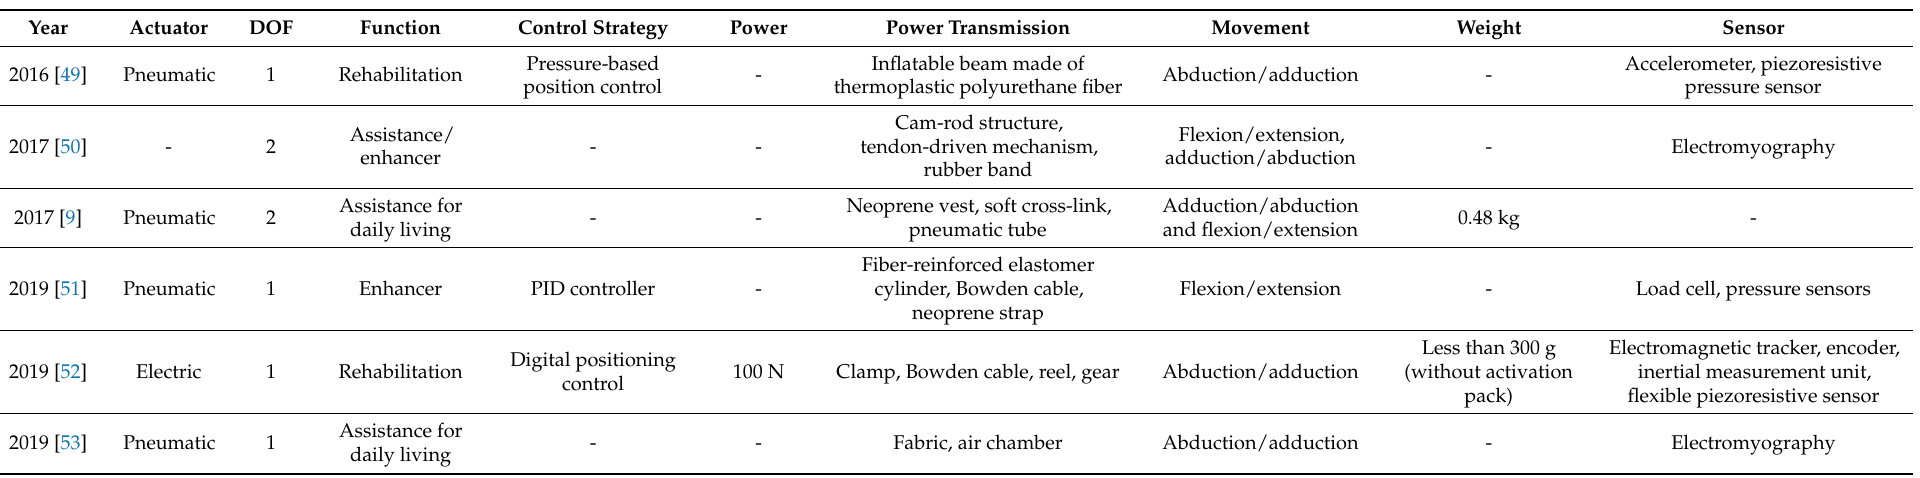
Table 1. Development of soft exoskeletons of the shoulder.